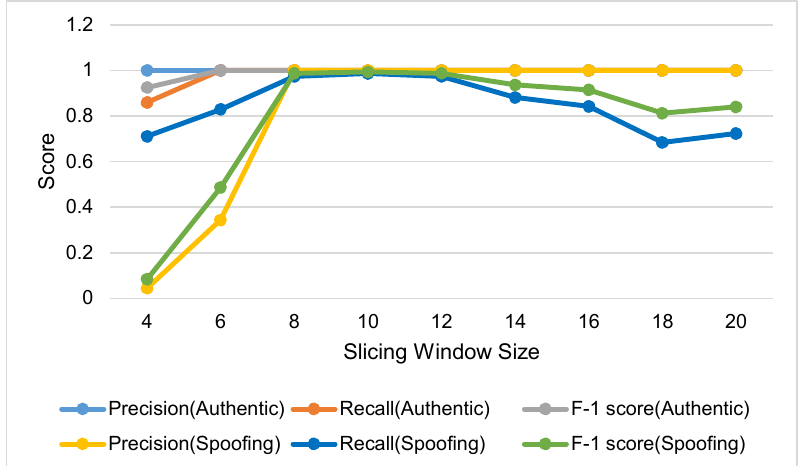
Figure 4. Precision, recall, and F ‐ 1 score with respect to slicing window size.